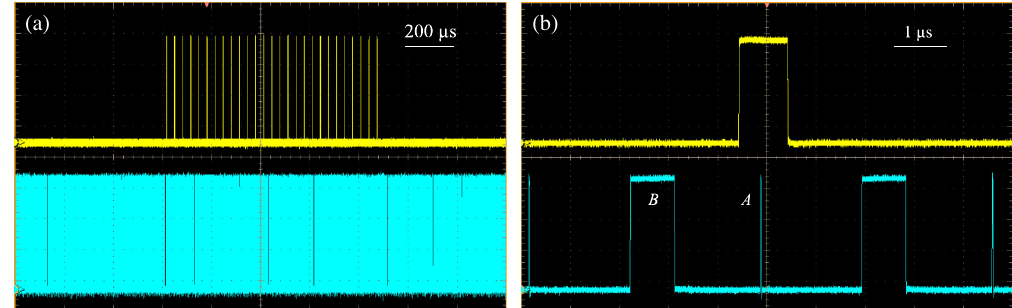
FIG. 5. Rf waveforms corresponding to (a) laser comb macropulse and (b) individual comb tooth. In each figure, the top waveform is the rf signal applied to AOM while the bottom waveform is the rf signal applied to EOM. A and B in (b) represent 20 ns and 900 ns pulse sequences,